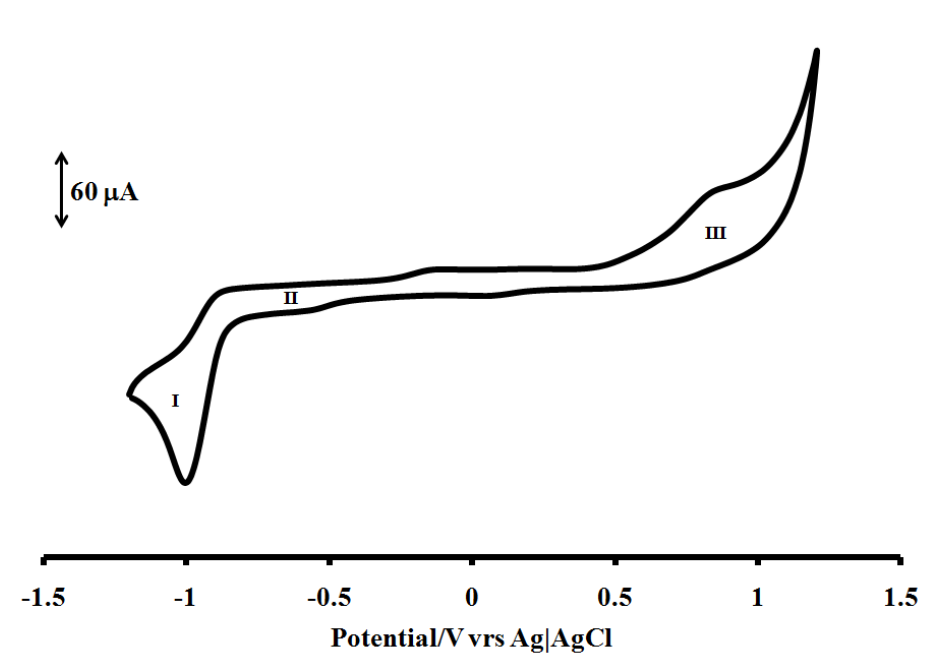
L (NCS) ] complex at 1 × 10 − 3 M in freshly 1 2 2 supporting electrolyte. Step potential = 5 4